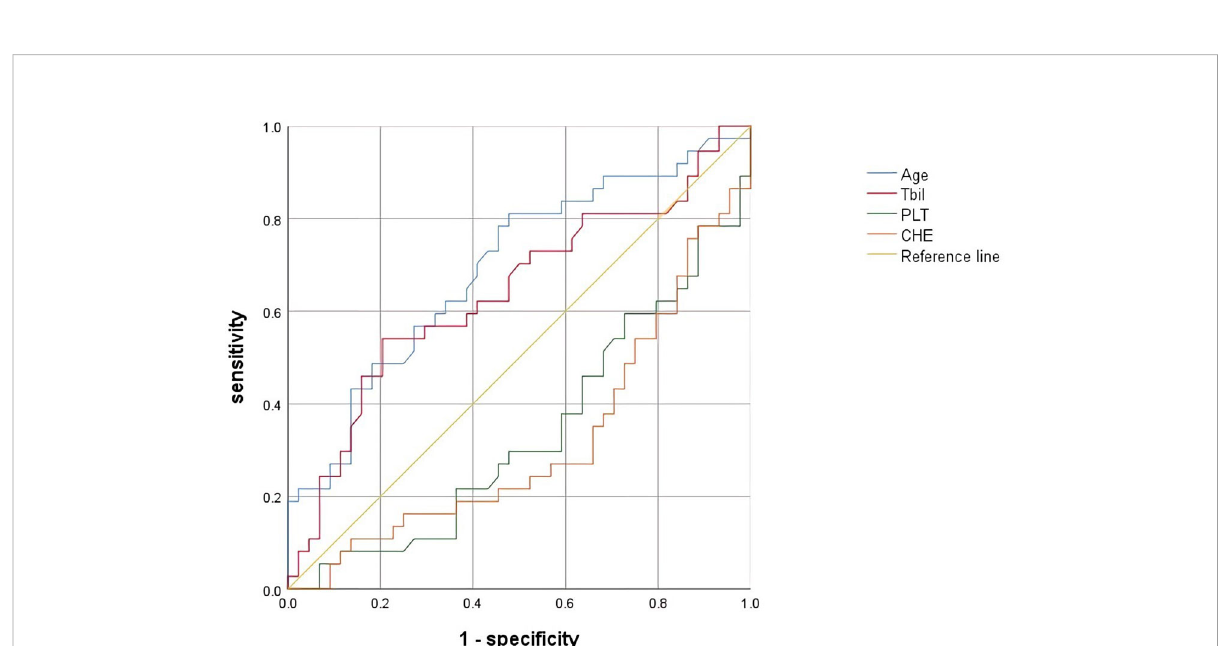
FIGURE 2 ROC of factors associated with signi fi cant hepatic histopathology. Abbreviations: CHE, cholinesterase; PLT, platelet; TBIL, total bilirubin; ROC, receiver operating characteristic curve.